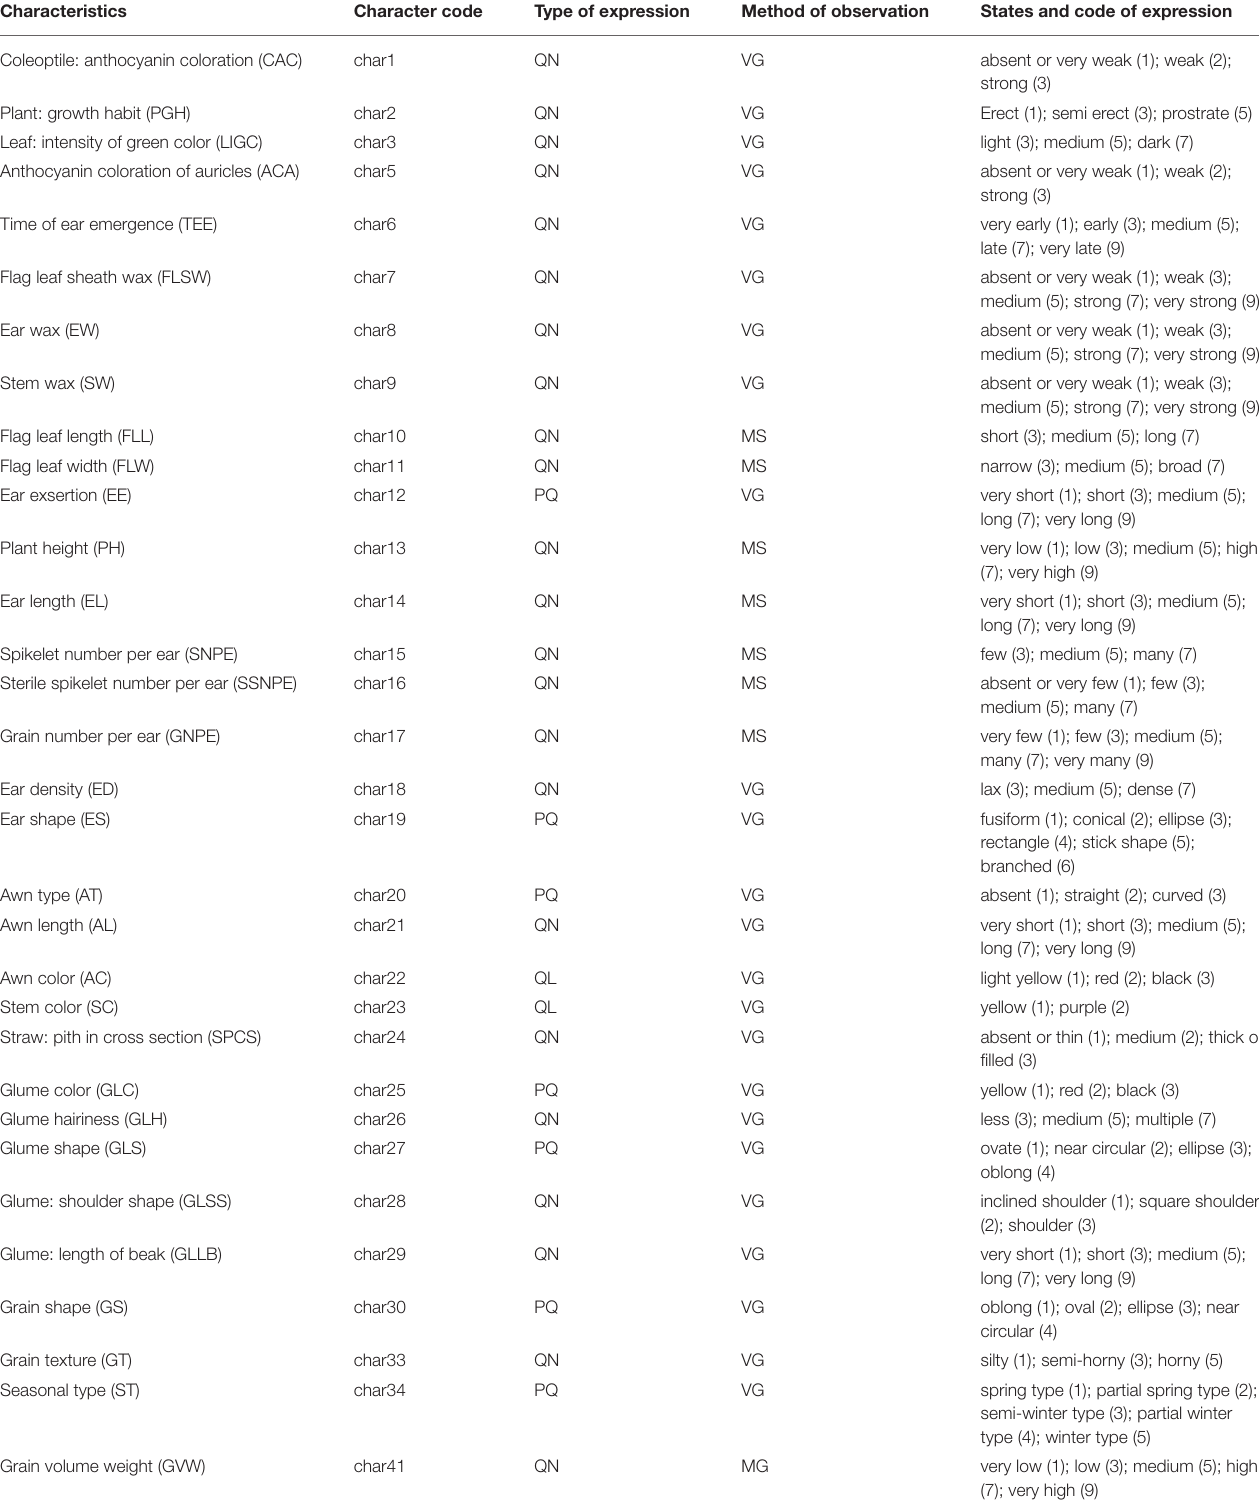
TABLE 1 | The information on wheat DUS testing characteristics used in this study. Characteristics Character code Type of expression Method of observation States and code of